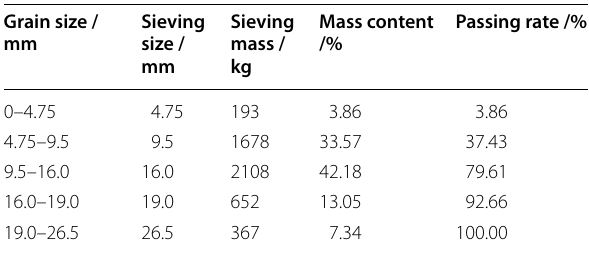
Table 3 Aggregate gradation.